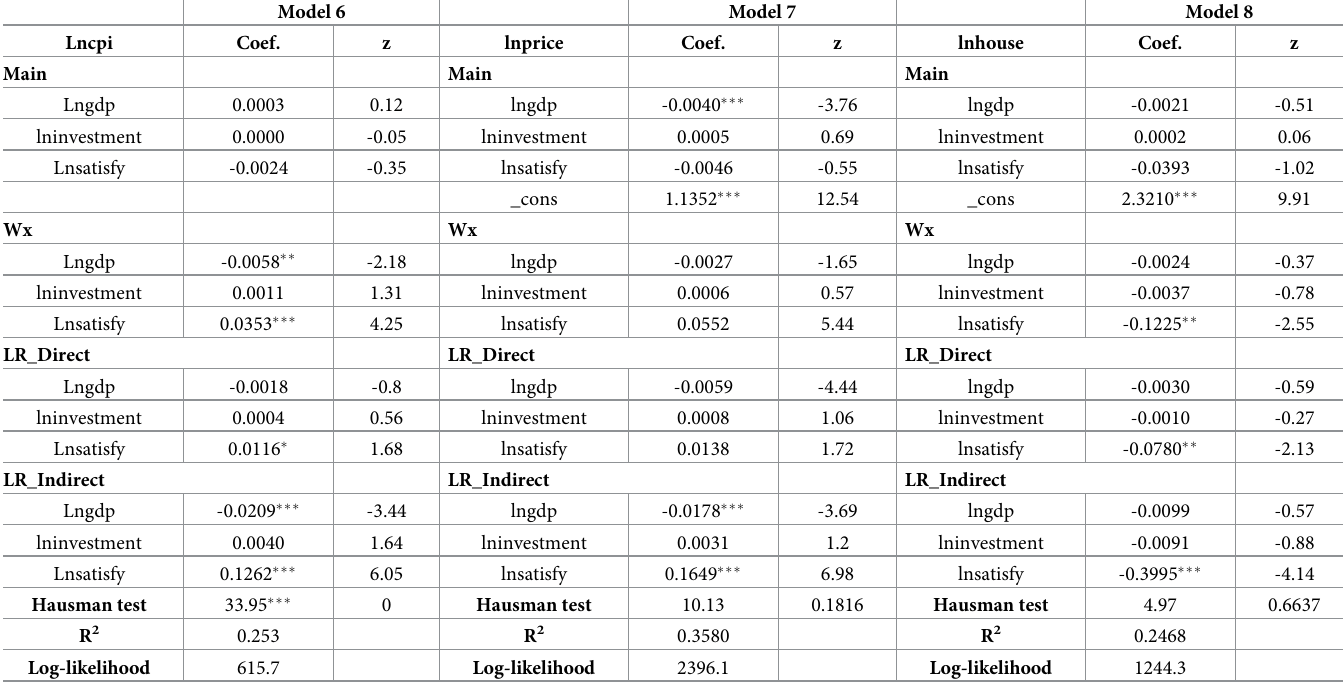
Table 8. SDM regression results for urban tourist satisfaction and urban cost of